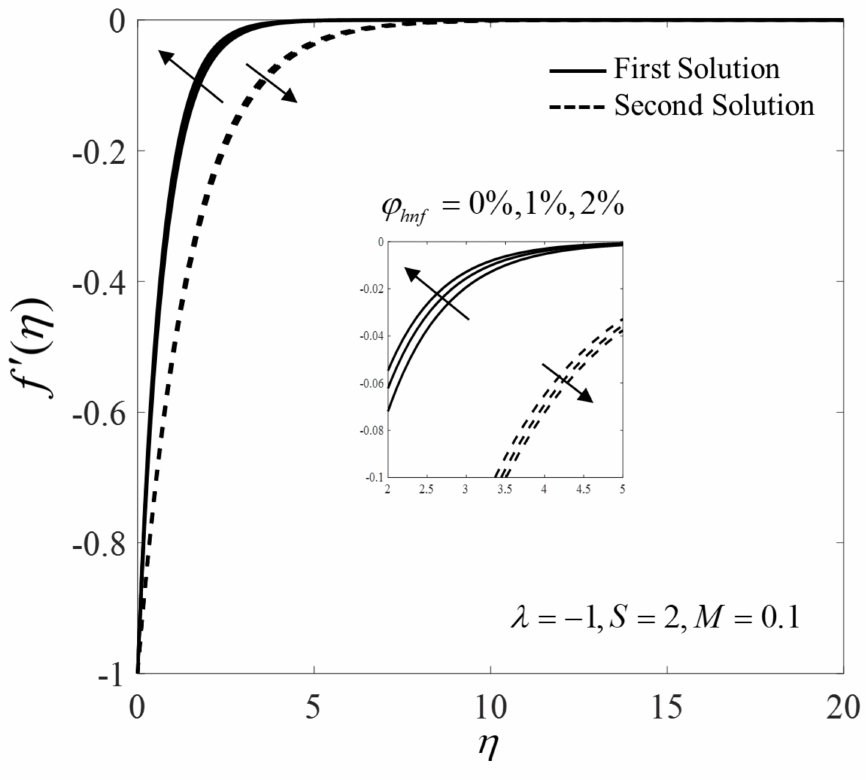
Figure 12. Velocity profiles f (cid:48) ( η ) for different values of ϕ hnf .